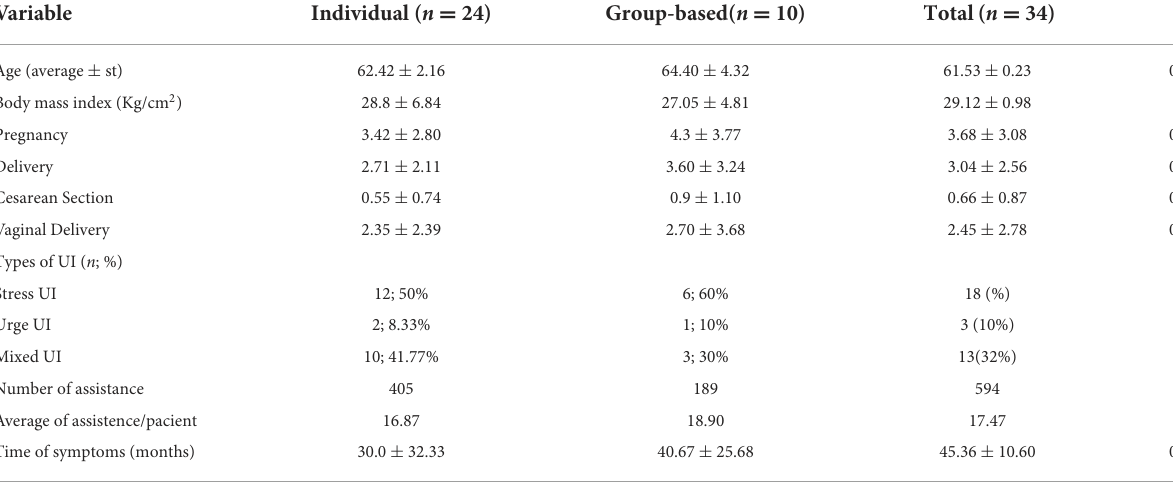
TABLE 1 Sample characteristics of participants in intervention study.